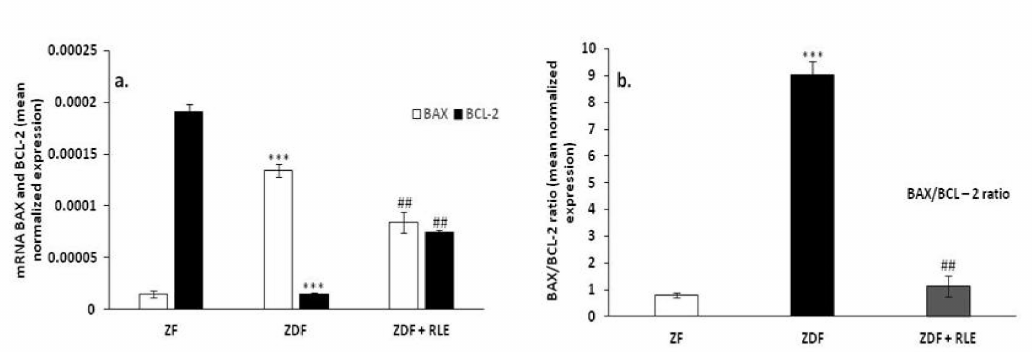
Figure 2. BAX, BCL-2, and BAX / BCL-2 ratio expression in the Zucker Fatty (ZF) ( n = 4), Zucker Diabetic Fatty (ZDF) ( n = 5), and Zucker Diabetic Fatty + red orange and lemon extract (ZDF + RLE) ( n = 5), after 24 weeks of treatment. ( a ) mRNA levels of BAX and BCL-2 in ZF, ZDF, and ZDF + RLE; and ( b ) BAX / BCL-2 ratio in ZF, ZDF, and ZDF + RLE. Experiments were conducted in triplicates, and the values are presented as mean normalized expression (MNE), normalized towards 18S expression (mean ± standard error). *** p < 0.001 versus ZF, ## p < 0.01 versus